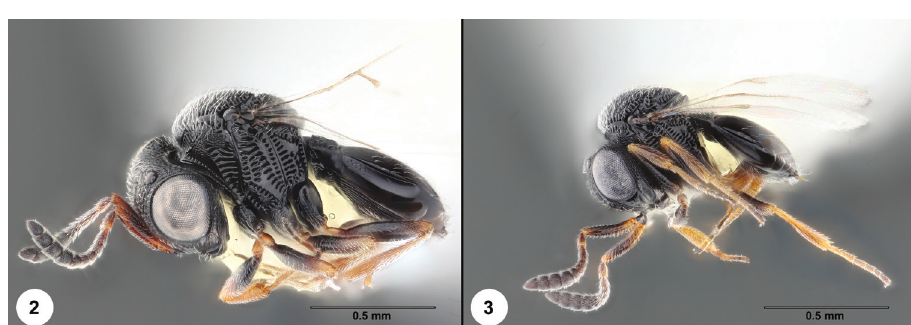
Figures 2–3. Psix striaticeps, habitus, lateral view. Images are presented at identical scale size to illustrate intraspecific size variation 2 female (FSCA 00095801) 3 female (FSCA